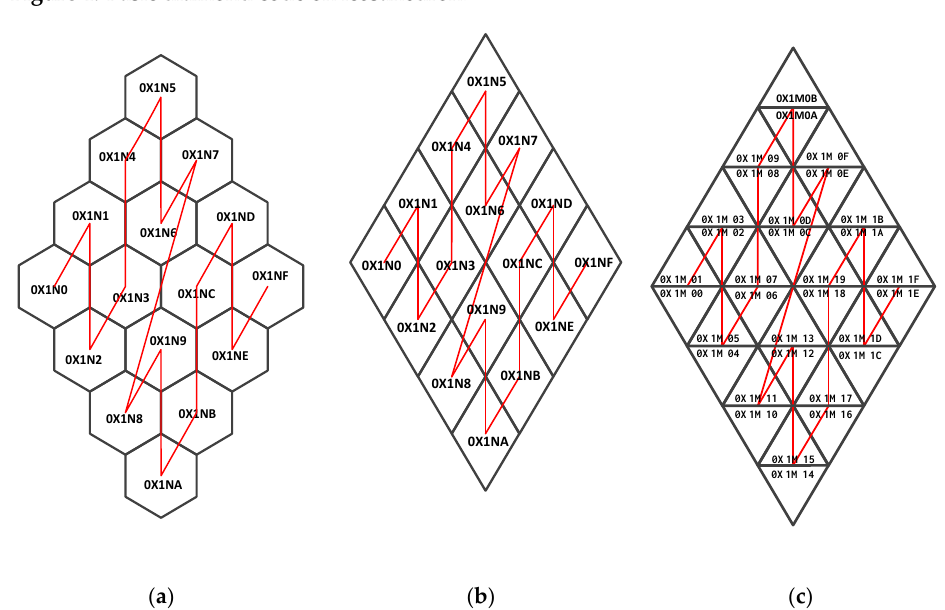
Figure 4. Basic diamond code on icosahedron.